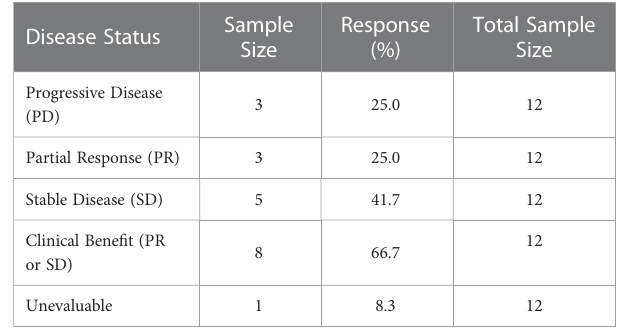
TABLE 3 Overall response rate at 12